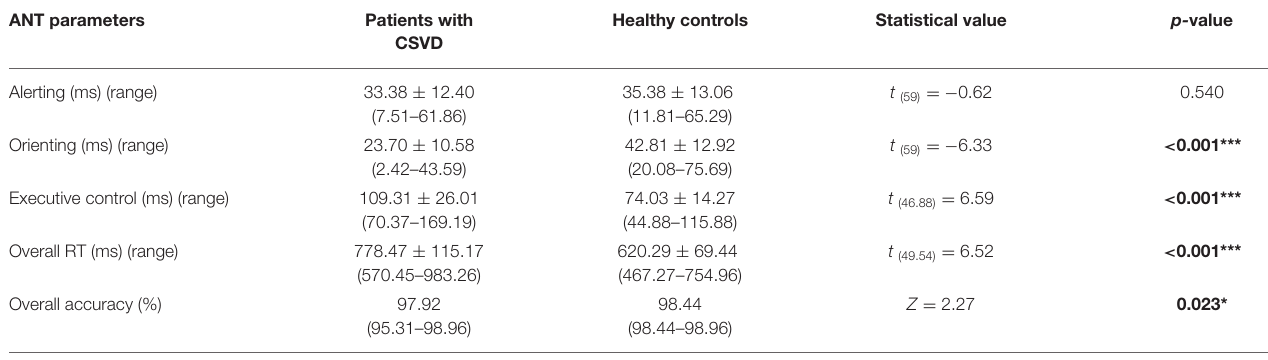
TABLE 4 | Attention network efficiencies of patients with CSVD and healthy controls. ANT parameters